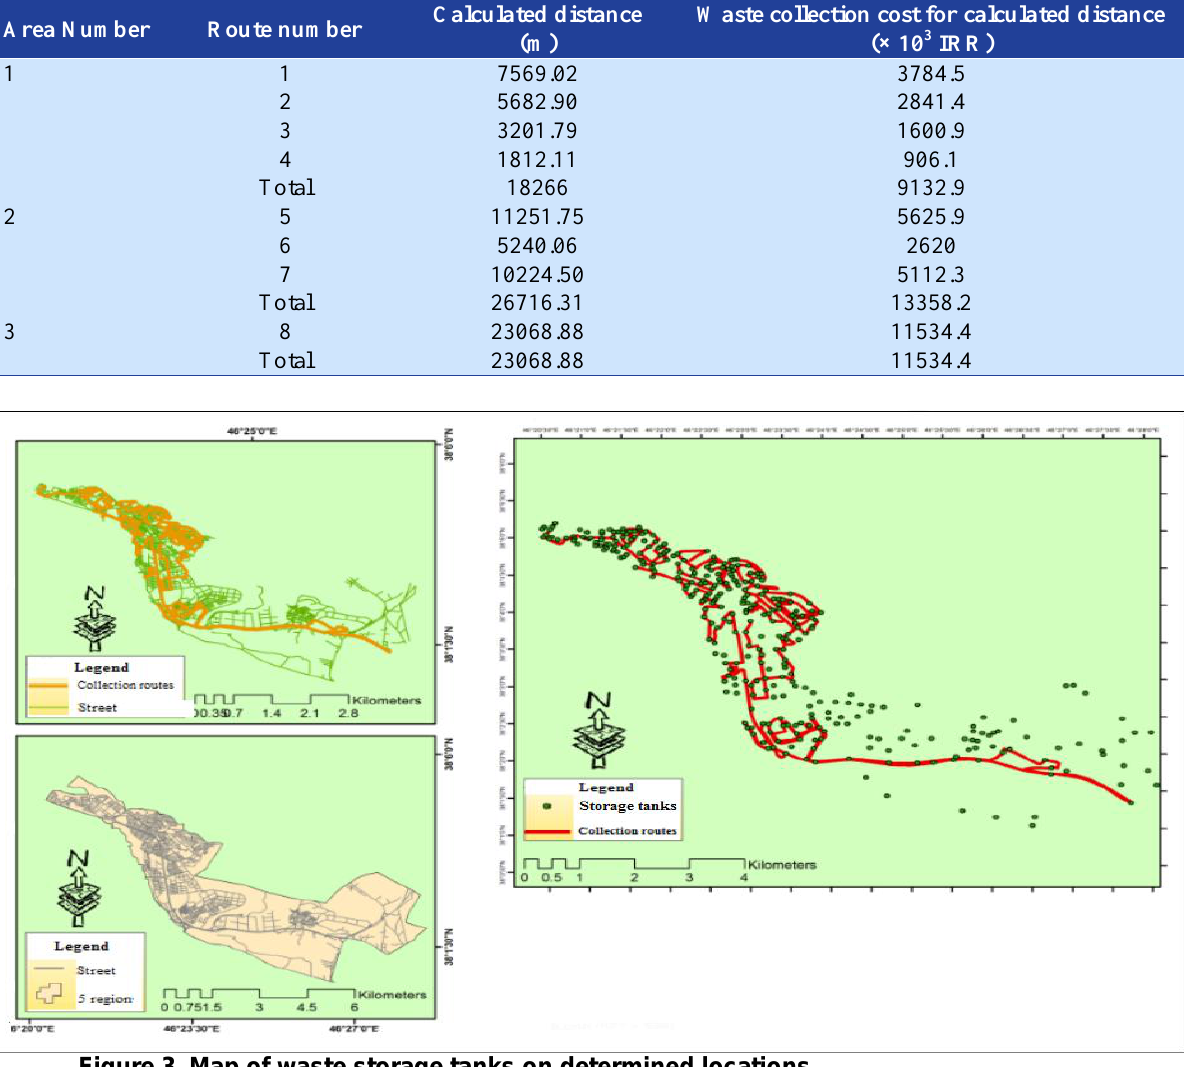
Table 5. The waste collection and transportation cost of every route of the study area Area Number